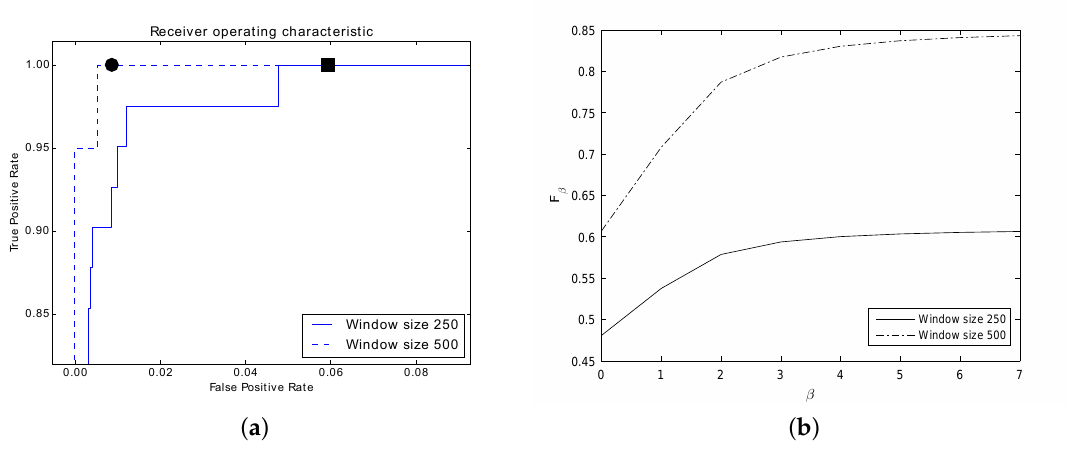
Figure 12. Resulting curves showing the classifier’s performance for the controlled flood attack. ( a ) ROC curves for both windows, 250 and 500; ( b ) F β curves for both windows, 250 and